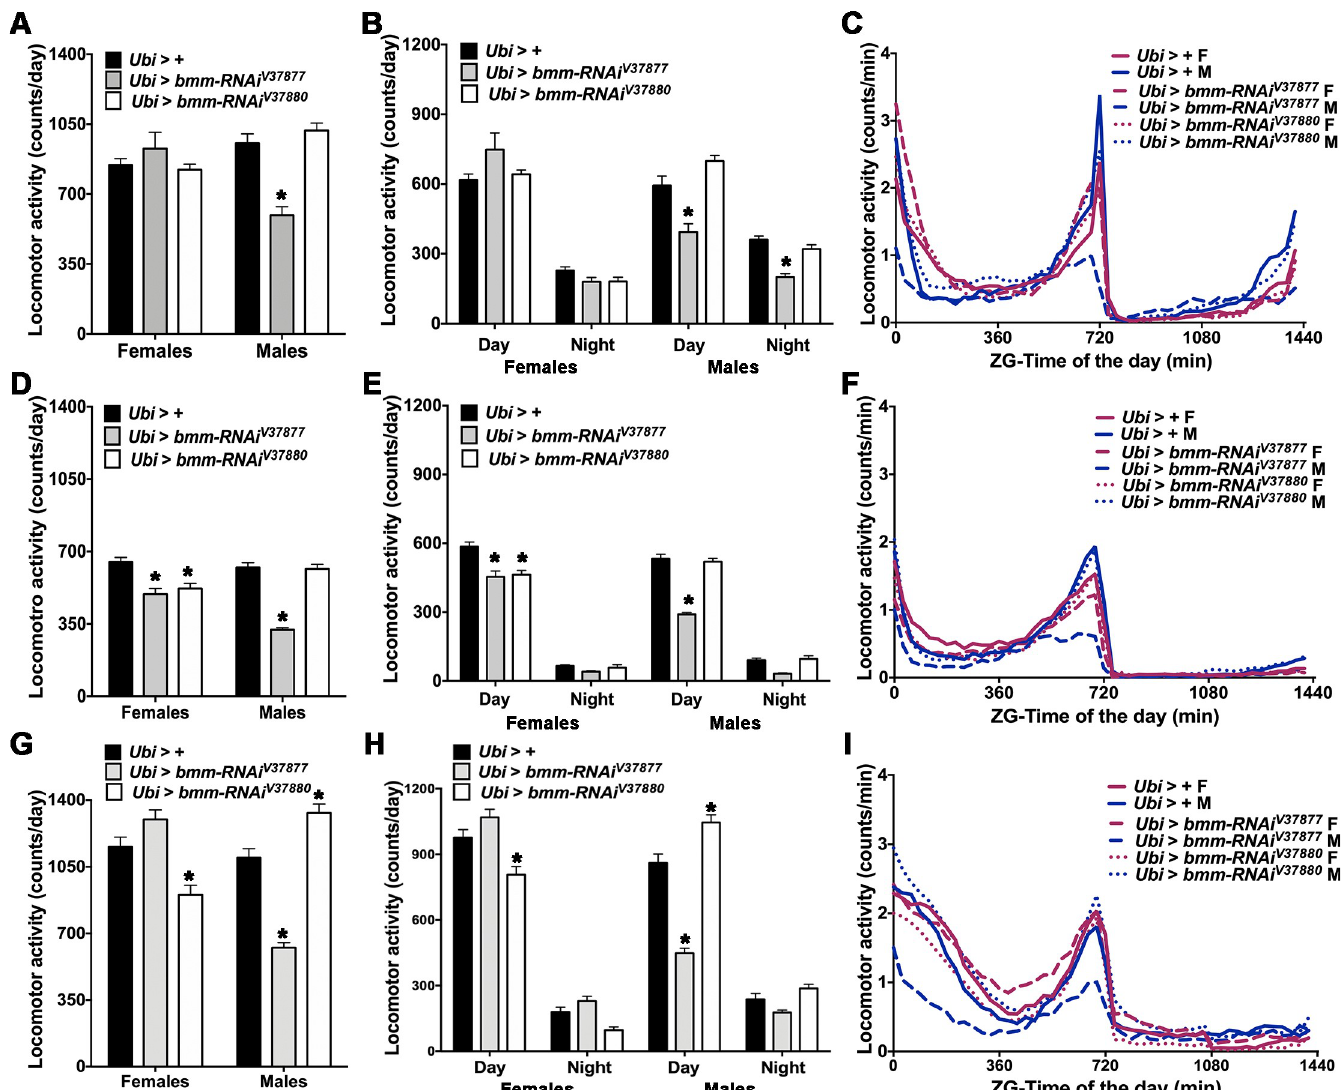
Fig 2. Locomotor activity in Ubi > bmm-RNAi flies. Offspring of Ubi-Gal4 mated with GD control ( Ubi > +) or UAS-bmm-RNAi flies ( Ubi > bmm-RNAi V37877 and Ubi > bmm-RNAi V37880 ) were used for the locomotor activity assay in normal feeding (a-c), normal feeding without wings (d-f) and starvation conditions (g-i). (a, d and g) Average of daily locomotor activity. (b, e and h) Average of locomotor activity during the daytime and nighttime. (c, f and i) Average activity profiles in Zeitgeber (ZG) time. Averages were calculated from 7 days of the behavior assays except for starvation, which was measured over 3 days. For this figure and Fig 3, “n” for normal feeding in females (F) and males (M) were: Ubi > + F (n = 49), Ubi > + M (n = 57), Ubi > bmm-RNAi V37877 F (n = 54), Ubi > bmm-RNAi V37877 M (n = 53), Ubi > bmm-RNAi V37880 F (n = 57) and Ubi > bmm-RNAi V37880 M (n = 62); “n” in normal feeding without wings were: Ubi > + F (n = 64), Ubi > + M (n = 62), Ubi > bmm-RNAi V37877 F (n = 56), Ubi > bmm-RNAi V37877 M (n = 55), Ubi > bmm-RNAi V37880 F (n = 58) and Ubi > bmm-RNAi V37880 M (n = 61); “n” in starvation were: Ubi > + F (n = 56), Ubi > + M (n = 42), Ubi > bmm-RNAi V37877 F (n = 54), Ubi > bmm-RNAi V37877 M (n = 52), Ubi > bmm-RNAi V37880 F (n = 63) and Ubi > bmm- RNAi V37880 M (n = 63). Asterisks indicate significant differences at p < 0.05 compared with the appropriate female or male control, following Tukey’s correction for multiple tests. Error bars are SEM. ANOVA tests are reported in S2 Table. https://doi.org/10.1371/journal.pone.0255198.g002 RNAi V37877 females and starved Ubi > bmm-RNAi V3880 males slept less during the daytime and during the nighttime than the control (Fig 3I). Starved Ubi > bmm-RNAi V37877 males slept more during the daytime than the control (Fig 3I). In contrast, starved Ubi > bmm- RNAi V37880 males slept less during the daytime and nighttime than the corresponding control. Thus, effects of bmm expression on sleep patterns are condition-dependent and sex-dependent and vary with the extent of reduction in gene expression in the different RNAi lines.